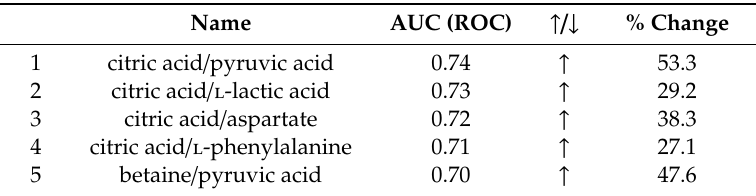
Table 2. Ratios of paired metabolites improve biomarker